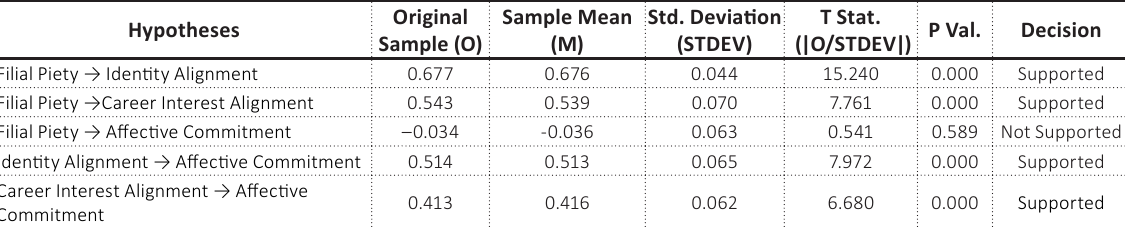
Source: Primary data